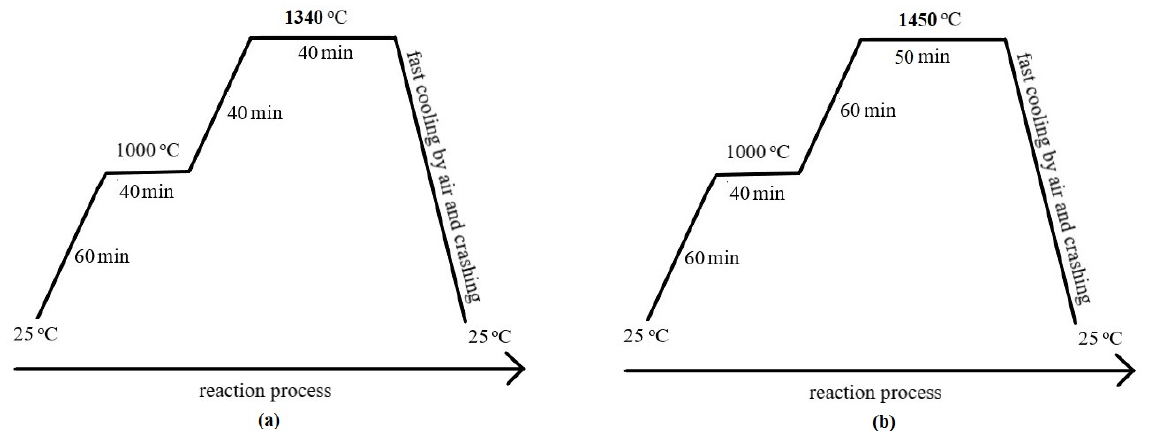
Figure 1. Diagram of firing temperature profile for the clinker preparation ( a ) at 1340 °C and ( b ) at 1450 °C.